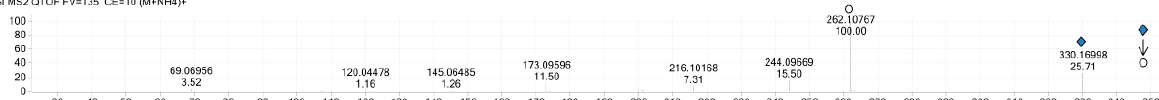
Figure 1. ( A ) HPLC of purified GKA201, GKB202, and GKC203 from ACM with retention time labeled at 5.063 for GKA201, 5.420 for GKB202, 7.285 min for GKC 203. ( B ) LC-QTOF/MS spectra of GKA201 with parent ion detected at m/z 313.14481; GKB202 with parent ion detected at m/z 463.26310; GKC203 with parent ion detected at m/z 330.16998.